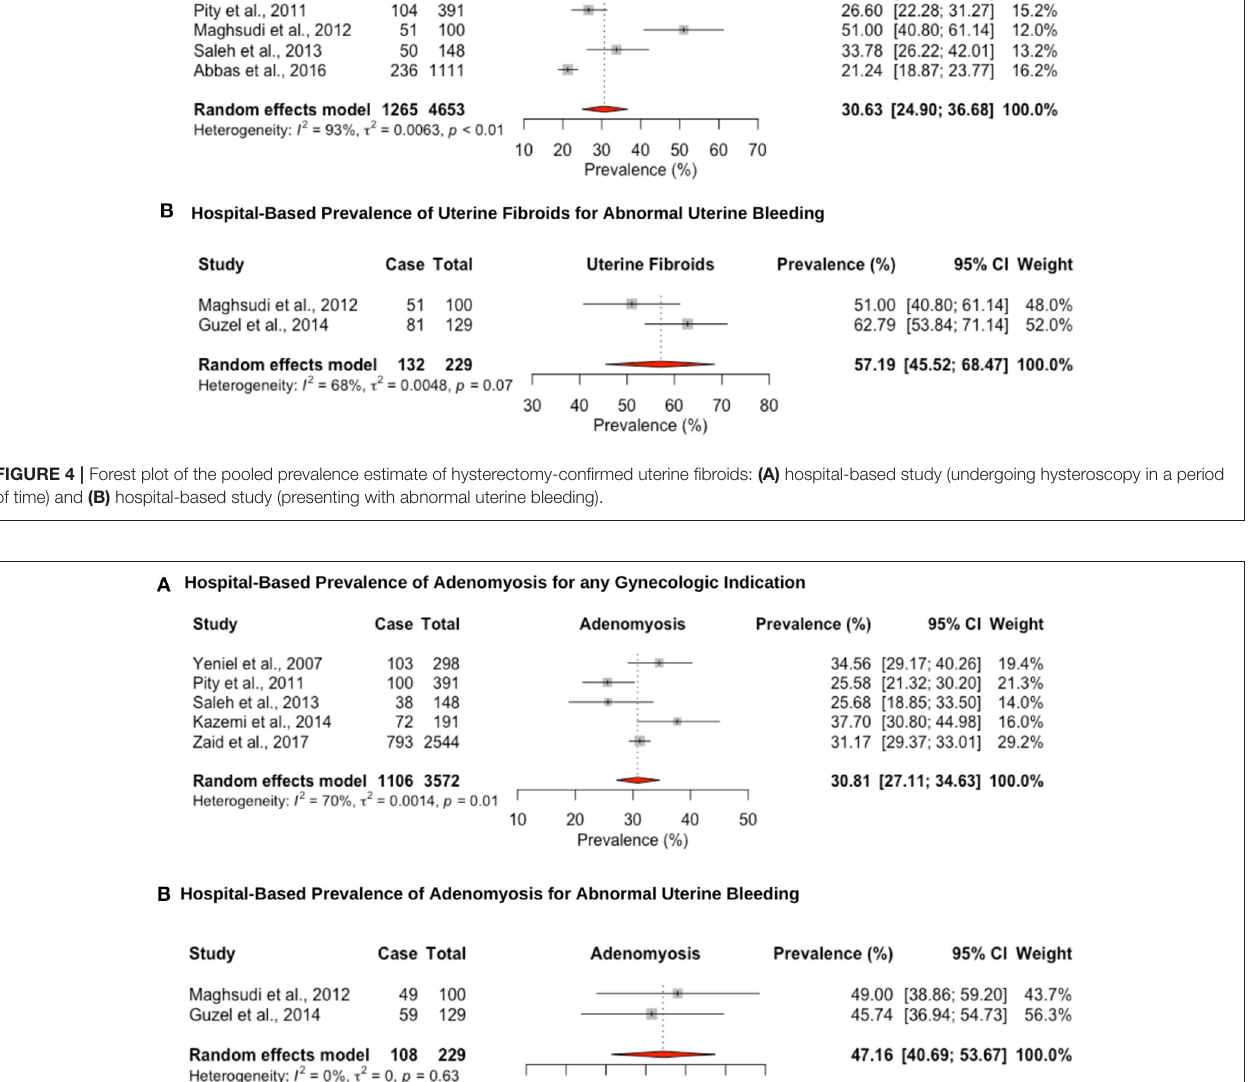
PCOS phenotypes (123). Additionally, high heterogeneity was reported due to variability of age group of the participants among studies, where post-menarche adolescent women and PCOS manifest similar clinical, metabolic, and endocrine